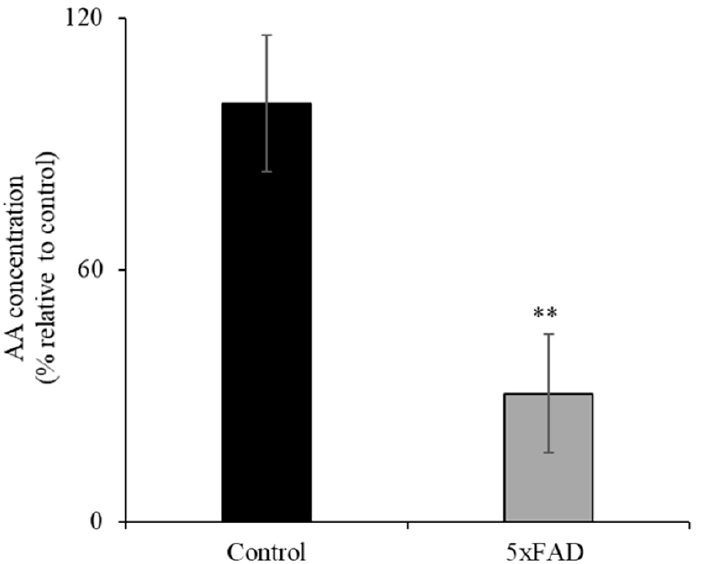
Figure 1. Decreased level of ascorbic acid (AA) in the serum of transgenic mice expressing five Familial Alzheimer’s Disease (5xFAD) mutations. AA levels were determined in 12 ‐ month ‐ old 5xFAD and wild ‐ type (WT) littermate mice serum using the Colorimetric Assay Kit II as described in the “Methods”. Values are means ± SE of at least four different mice ( n = 4). ** p < 0.05.